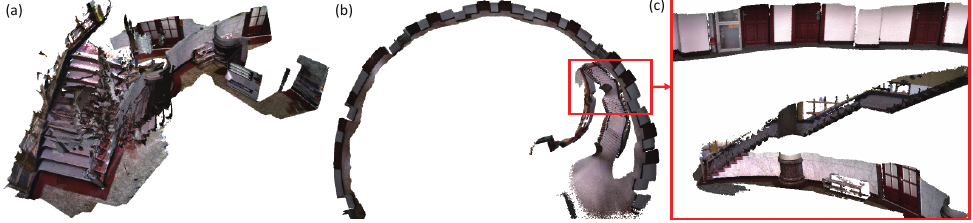
Figure 10. Reconstruction results of an arched department. ( a ) is produced by BundleFusion [33]. The system failed and gave an unsatisfactory result. ( b ) is produced by our system. ( c ) gives surface details on the stairs.